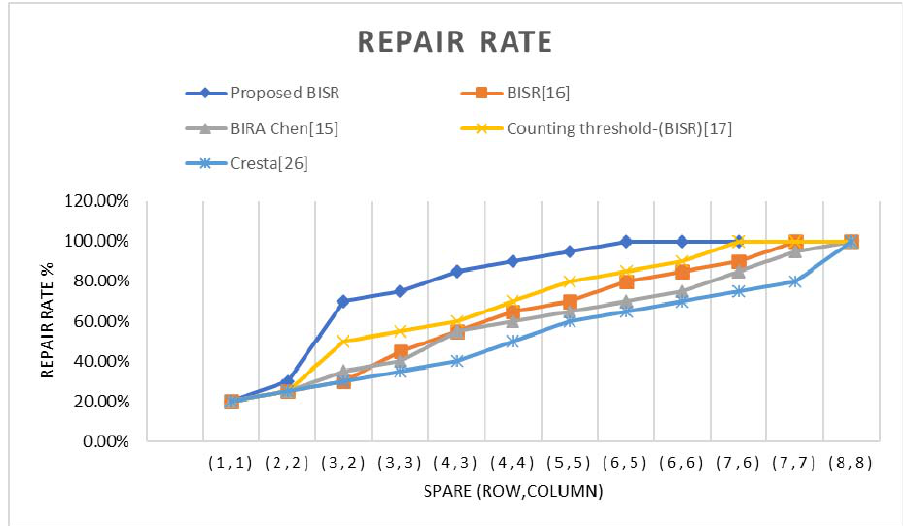
Figure 10. The estimated chart between repair ‐ rate percentage and the spare ‐ row/column